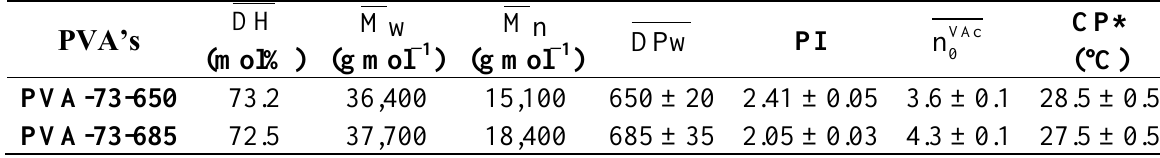
Table 1. Molecular characteristics of the poly(vinyl acetate- co -vinyl alcohol) (PVA) samples.